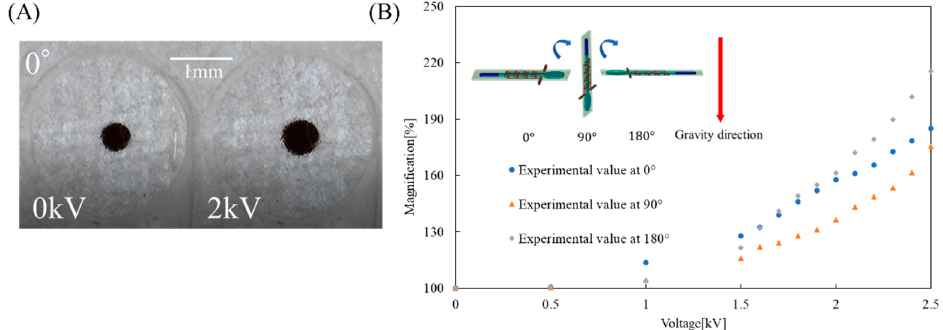
Figure 6. Image focus test. ( A ) Image focus test when the EHD lens is at 0° . ( B ) Results of image focus test at 0°, 90°, and 180°.